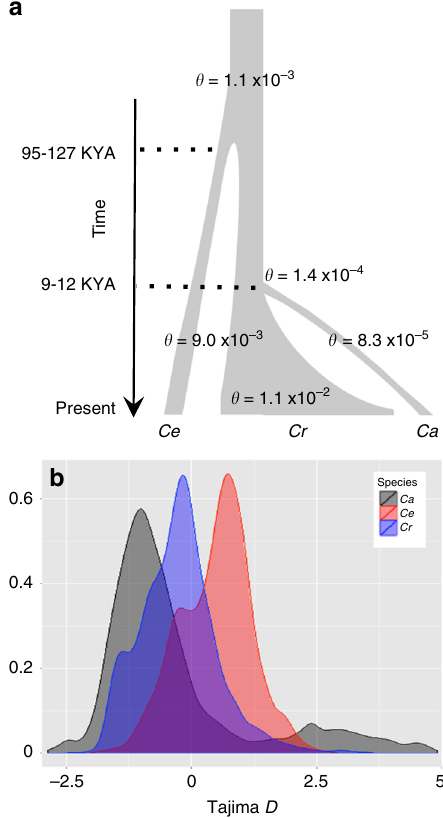
Fig. 5 A demographic model and genome-wide patterns of nucleotide variation in wild Cicer . a Demographic model implemented in G-PhoCS indicating divergence times and theta values based on standing variation present in 16,845 SNPs across each species. b Genome-wide estimates of Tajima ’ s D based on 100 bp sliding windows for C. reticulatum, C. echinospermum , and cultivated C.